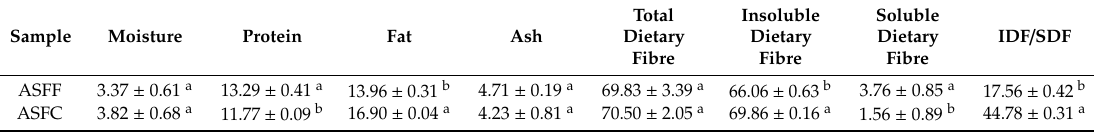
Table 1. Proximate composition of almond skin flours obtained from Turr ó n coproducts. Sample